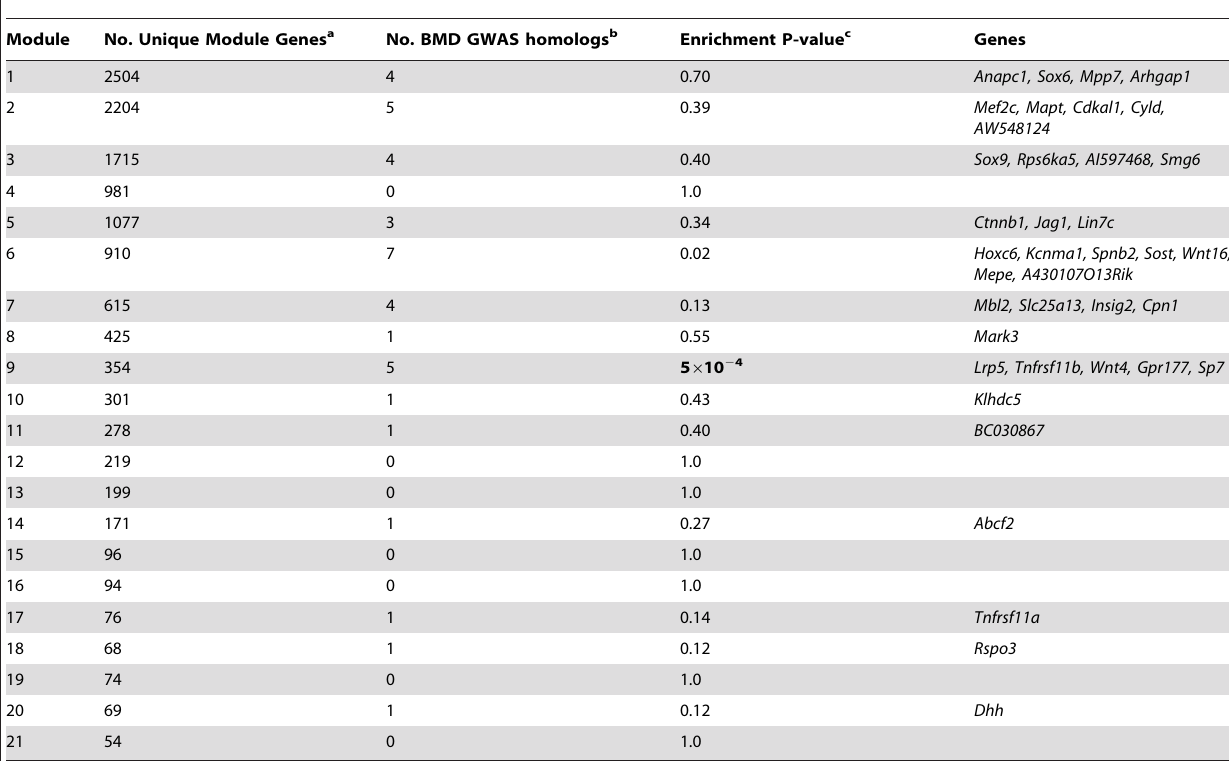
Table 5. Module 9 is enriched in homologs of human genes implicated in the regulation of BMD through genome-wide association